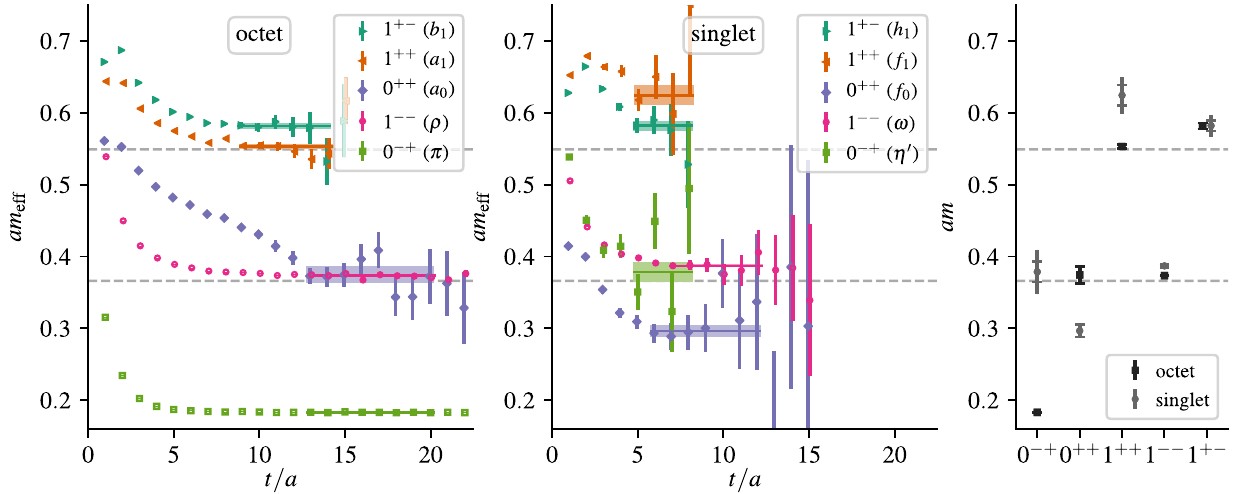
Fig. 5 The meson spectrum of ensemble H101. Effective masses are shown for each channel in the flavor octet (left) and singlet (center) sectors, along with bands indicating the plateau fits. Note that in many cases (in particular the octet pseudoscalar and vector channels), the error bar is smaller than the plotted symbol. Fitted masses are shown in